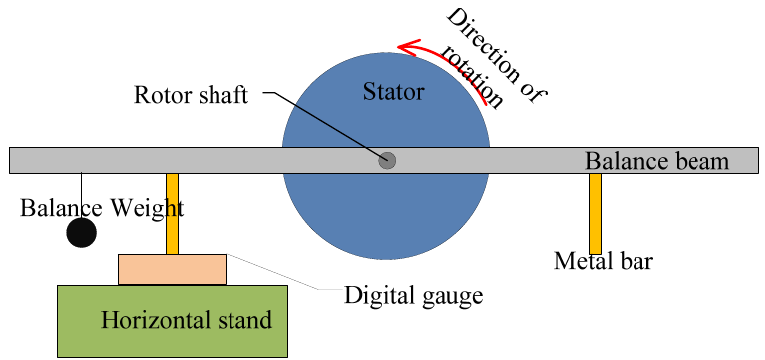
Figure 14. The principle of measurement.